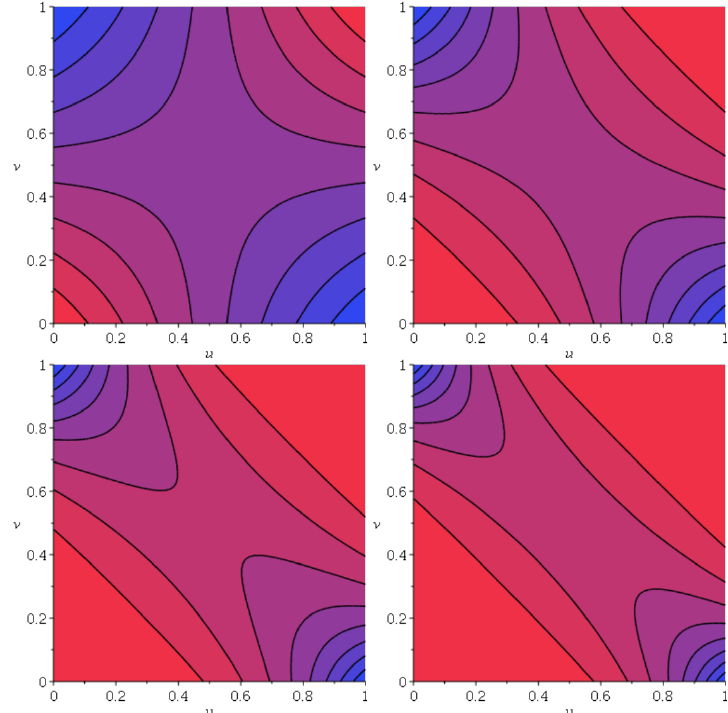
Figure 2: Illustration of the iterated transformation C k +1 = T ( I d , C k ) of C 0 := Π . From left to right and top to bottom: Contour plots of the densities associated with C 1 , . . . , C 4 . Red (resp. blue) color corresponds to small (resp. large) density